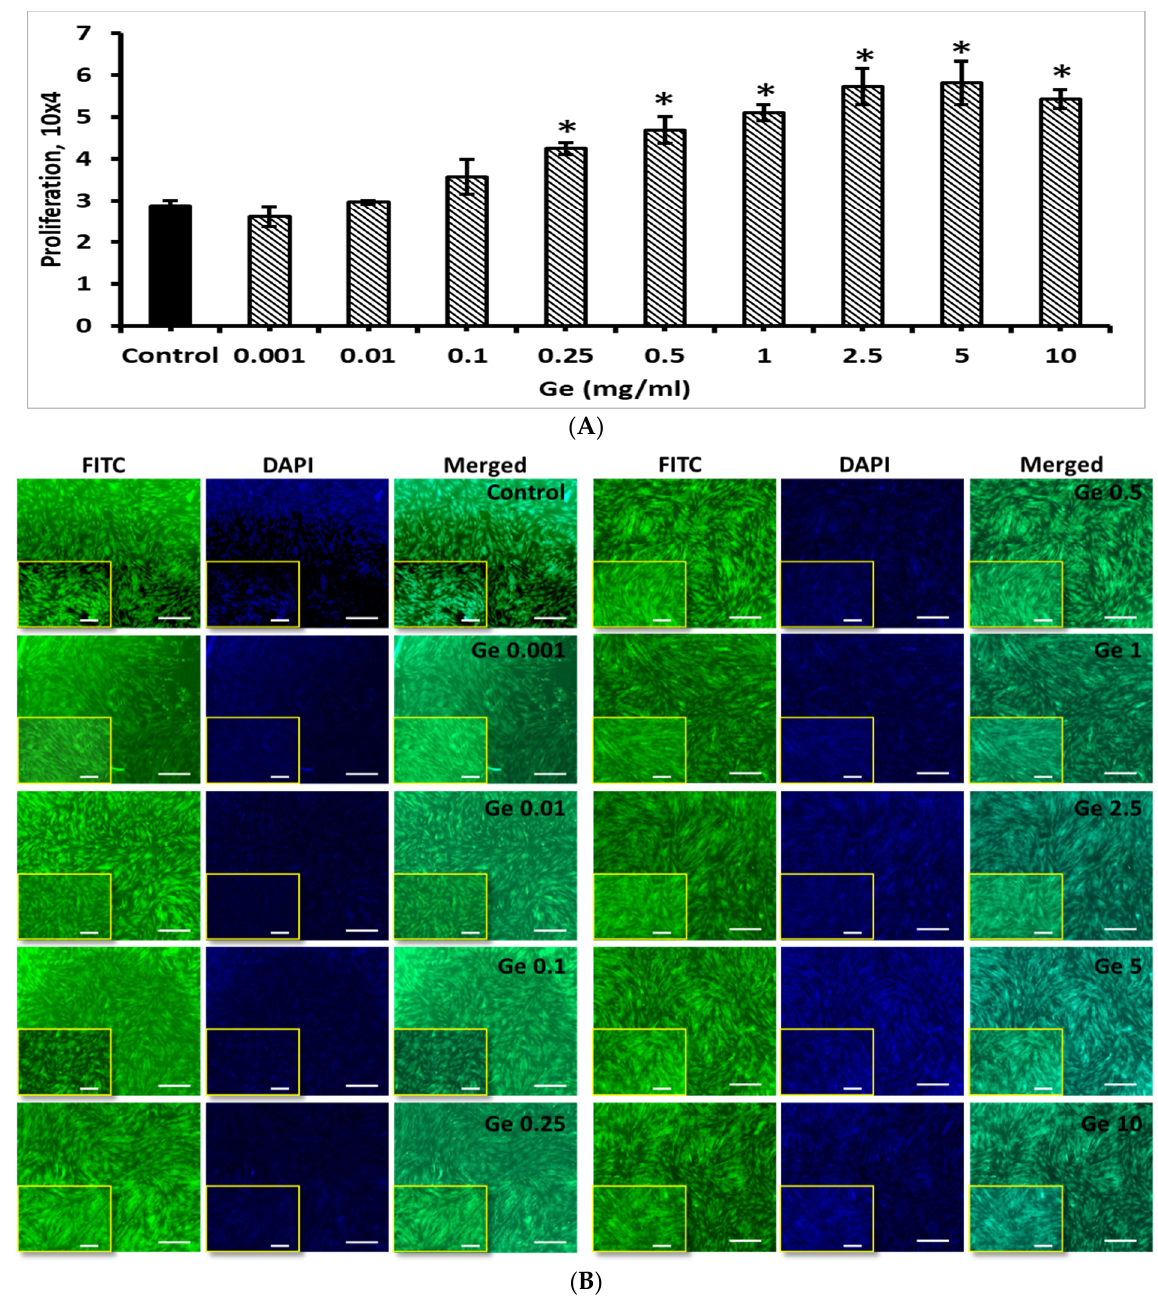
Figure 9. ( A ) Cell count and ( B ) Fluorescence (FITC, DAPI and merged) images of BM-MSCs cultured with Ge. Control—BM-MSCs cultured without Ge, Ge 0.001, 0.01, 0.1, 0.25, 0.5, 1.0, 2.5, 5 and 10 represent their respective concentration of Ge treated with BM-MSCs, respectively. Scale bar 5×-200 µm, 10×-100 µm (Insert) * denotes statistical significance, p <0.05 vs. control.